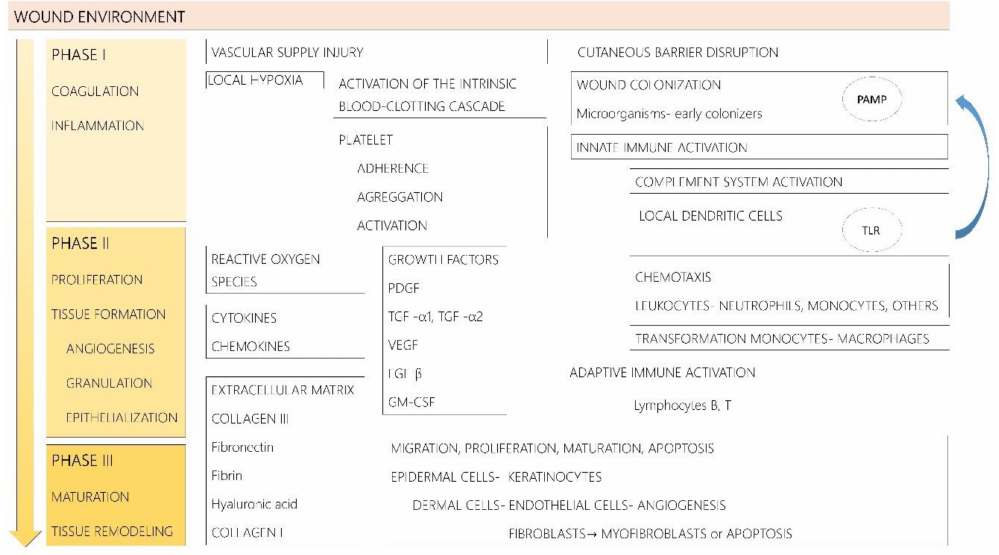
Figure 1. PDGF—platelet-derived growth factor; TGF- α 1, TGF- α 2—transforming growth factors alpha 1 and alpha 2; VEGF—vascular endothelial growth factor; FGF- β —fibroblast growth